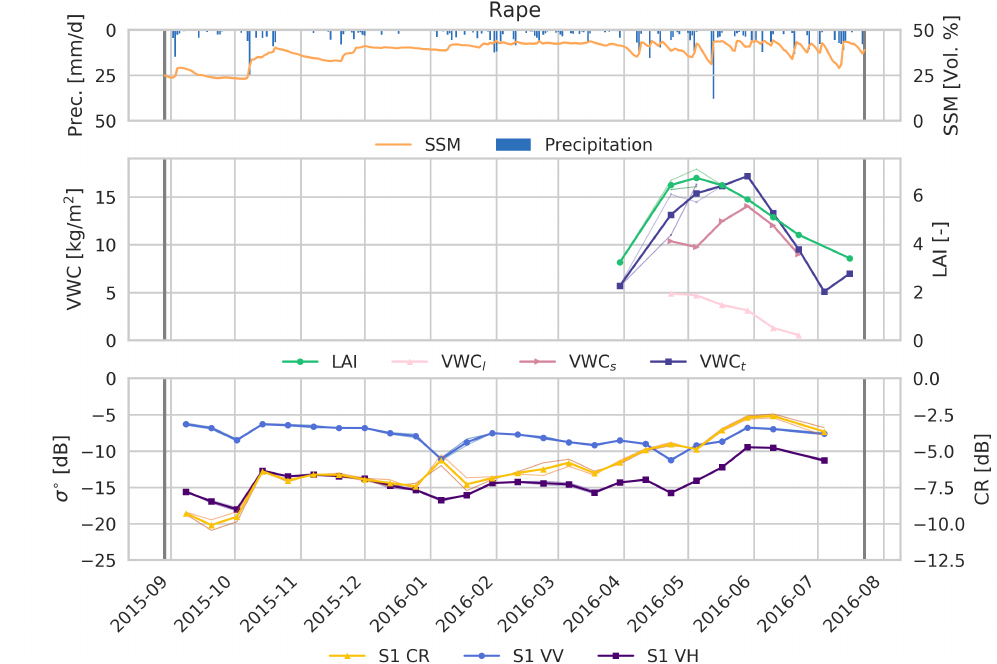
Figure 2. Time series of precipitation (blue) and soil moisture at 5 cm depth (orange) (top). Total VWC (VWC t , blue), stems (VWC s , pink) and leafs (VWC l , light pink), LAI (green) (middle). S-1 VH (dark blue) and VV (light blue) and CR (yellow) (bottom). The separate fields are indicated with transparent lines. Grey vertical lines are planting and harvesting dates.